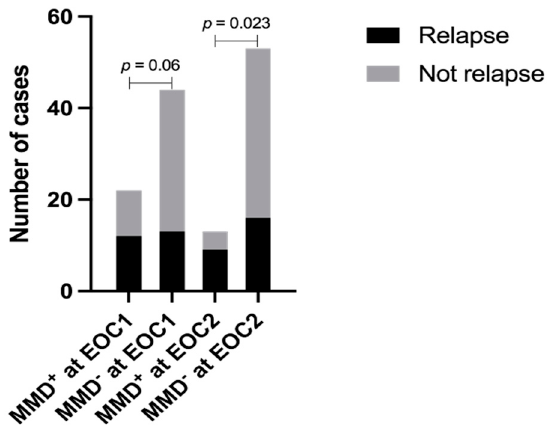
Figure 2. Correlation of MMD status at EOC1 and EOC2 with relapse. MMD, minimal measurable disease; EOC1, end of cycle 1 induction; EOC2, end of cycle 2 induction.